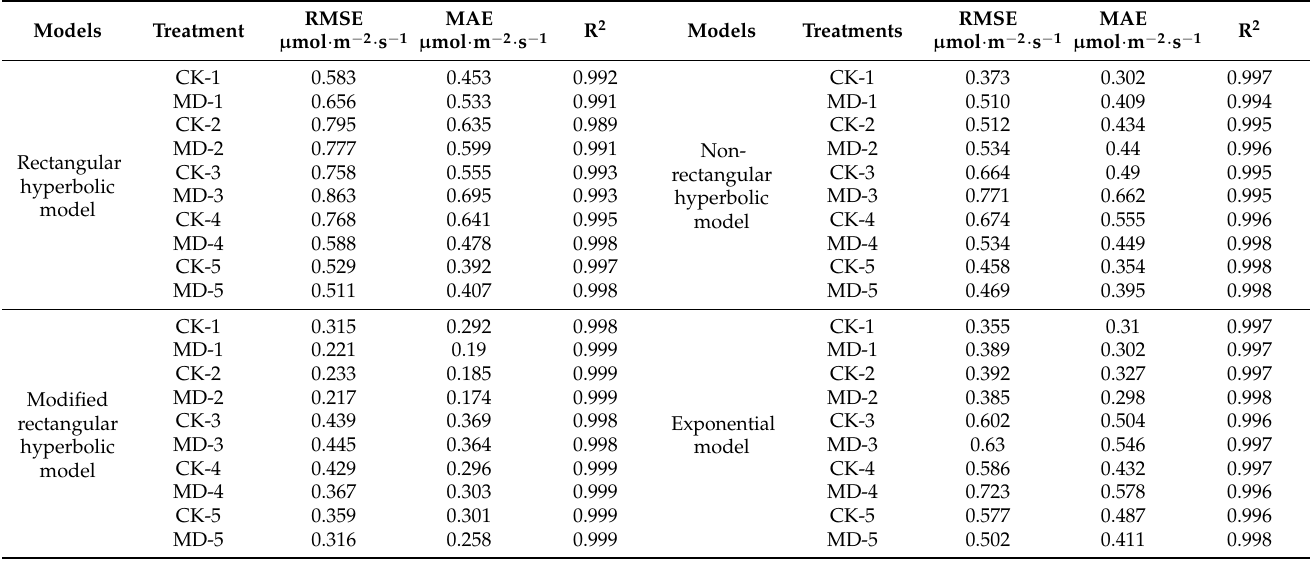
Table 5. Precision comparison of simulation values of light response curves by four light response